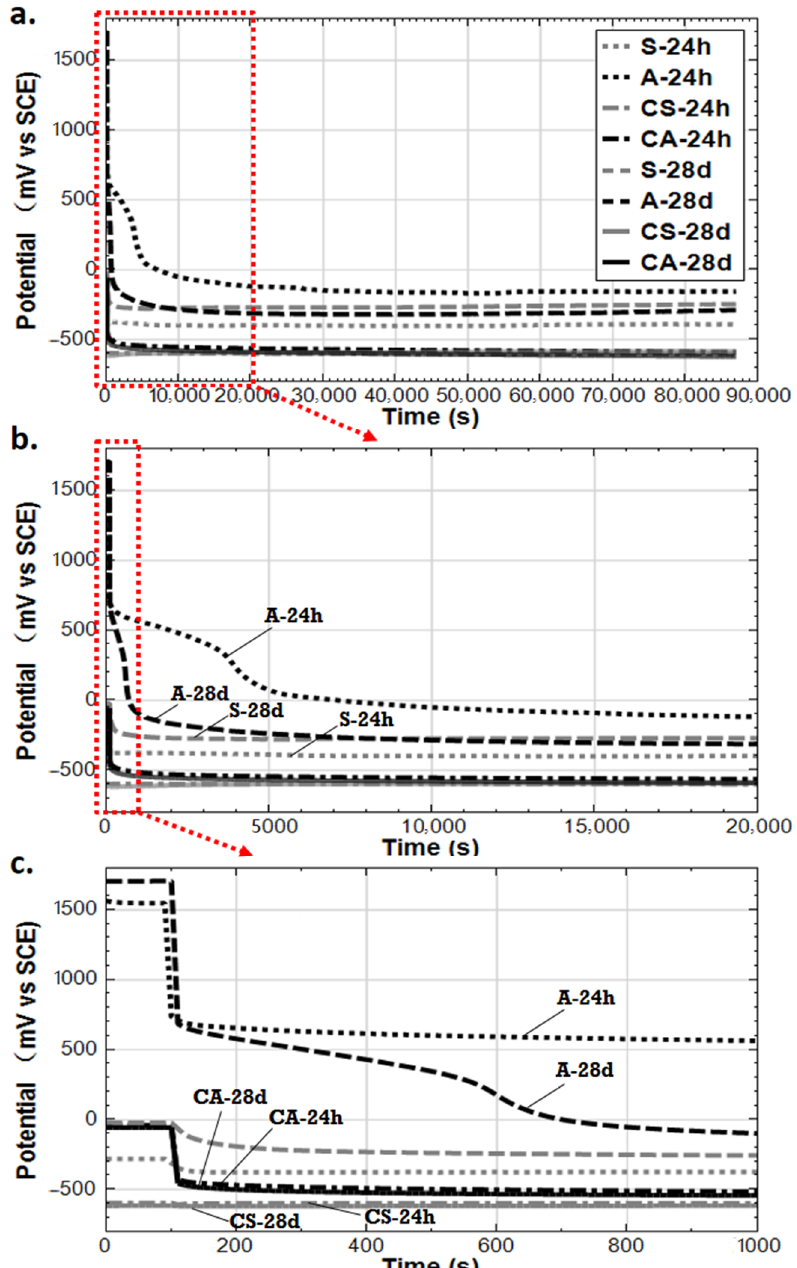
Figure 19. Potential decay monitoring over 24h de-polarization process (S-24h: Stray Current; CS-24h: NaCl + Stray Current; A-24h: Anodic Polarization; CA-24h: NaCl+ Anodic Polarization—After 24h curing; S-28d: Stray Current; CS-28d: NaCl + Stray Current; A-28d: Anodic Polarization; CA-28d: NaCl + Anodic Polarization—After 28d curing). ( a ) Full time scale; ( b ) Time scale of 0–20,000 s; ( c ) Time scale of 0-1000 s.